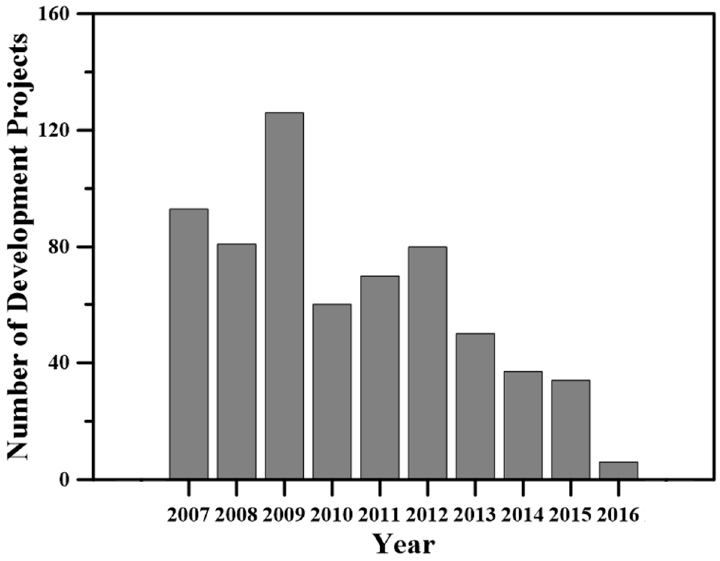
Figure 1. Temporal distribution of the development projects used in this study.